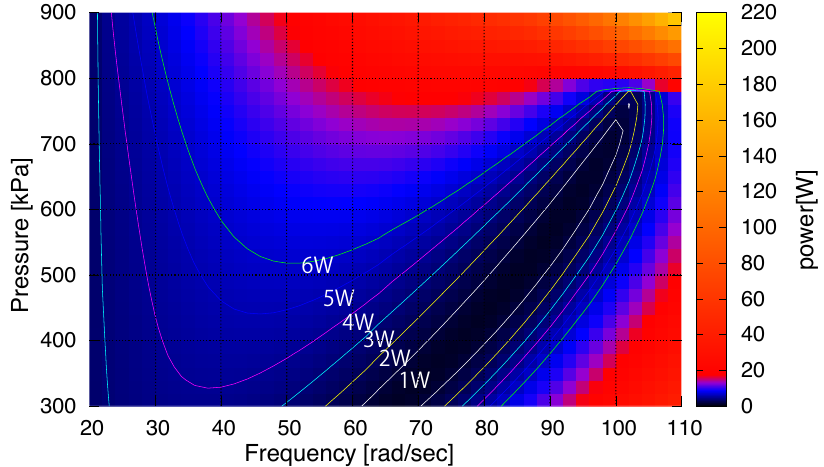
Figure 8. The relationship between the desired periodic movement frequency, the PAM preloaded pressure and the EM peak power. Defining ω as the periodic motion frequency, the desired mass position is given by p ( t ) = 0.3 + 0.01sin ( ω t )